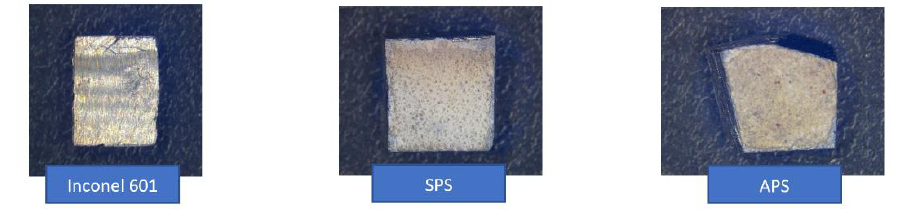
Figure 5. Samples.